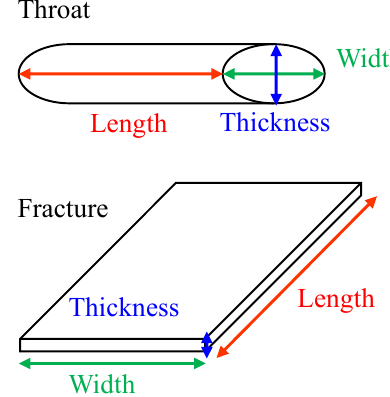
Figure 5. Illustration of the difference between a throat and a fracture in geometry. The lengths of a throat and a fracture are both usually significantly longer than their widths and thicknesses. The difference is that the width and the thickness of a throat are close while the width of a fracture is usually significantly longer than the thickness of it. To avoid mistakenly acquire a throat as a fracture, both the ratios of length over thickness and width over thickness should be large.